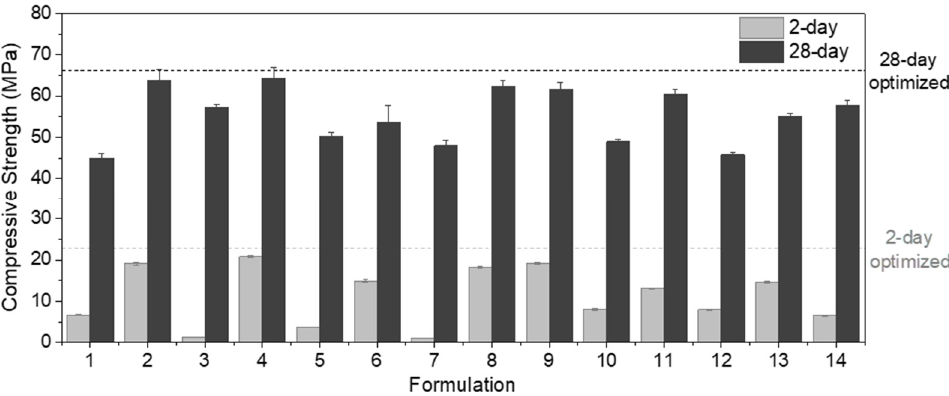
Figure 8. 2-day and 28-day compressive strength results of all